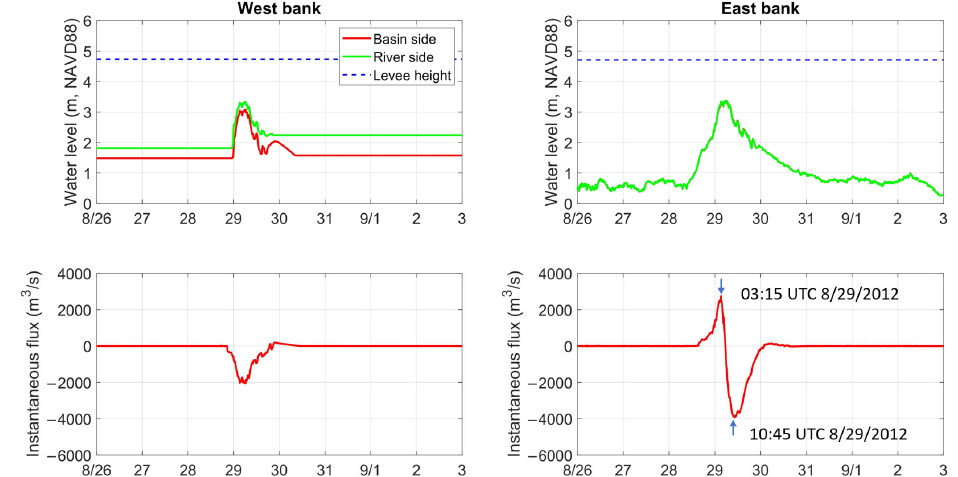
Figure 7. Time series of water level (m, NAVD88, top) and instantaneous flux (m 3 /s, bottom) for west (left two) and east (right) banks at the upper ‐ crossing location in the both ‐ crossing case during Isaac (2012). The direction of positive flux is from west to east.